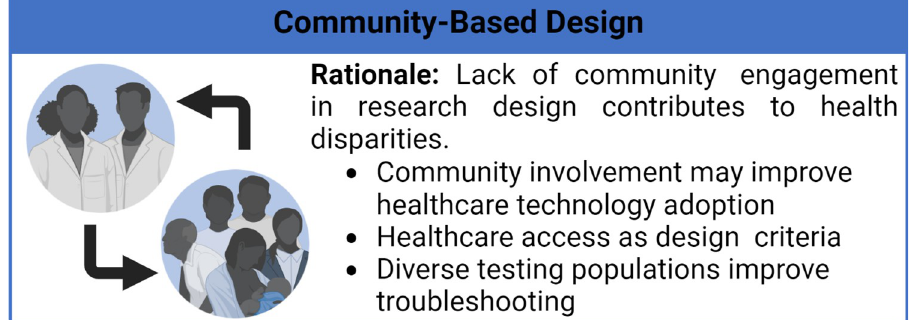
Fig 4. Rationale for prioritizing community-based design and takeaways from Rules 8 through 10. Image created with BioRender.com.